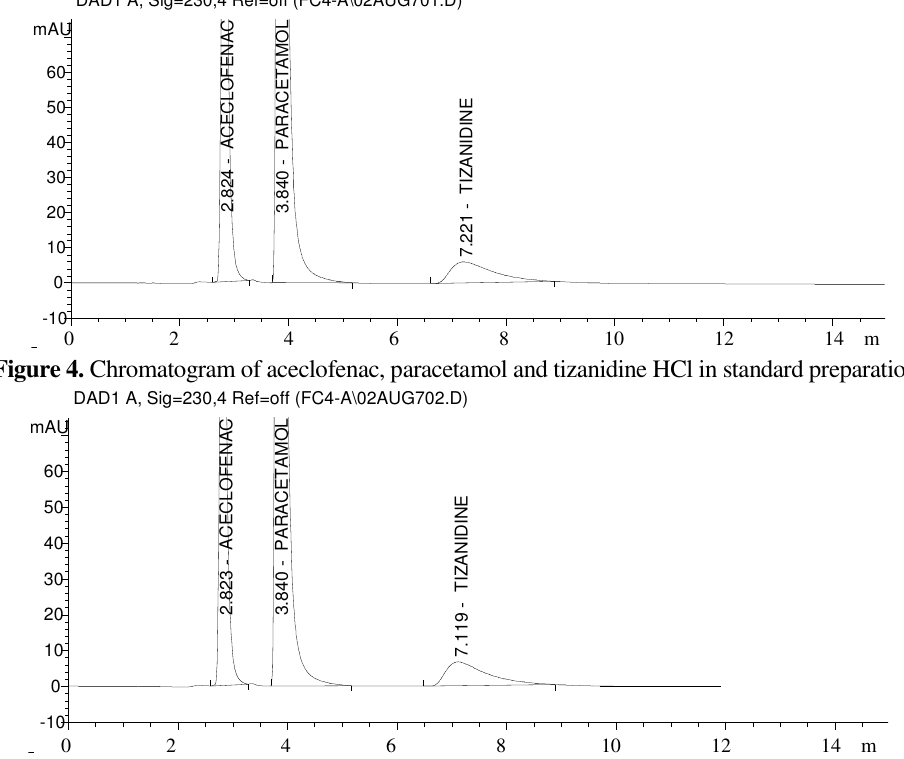
Figure 4. Chromatogram of aceclofenac, paracetamol and tizanidine HCl in standard preparation.